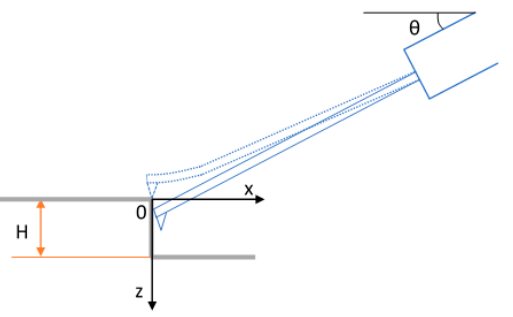
Figure 2. The deflection of the microprobe changes after passing the starting point of the falling edge (position 0) of the step